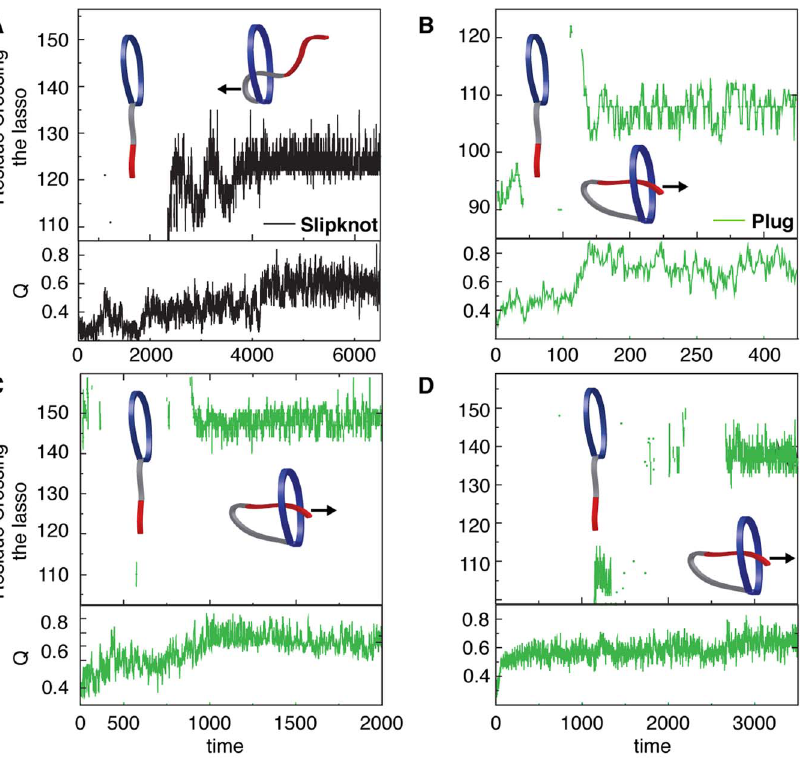
Figure 5. The threading mechanism of the N-terminal PLB proteins. ( A ) The threading mechanism for mIL-3 where slipknotting is the major event (black). We also observe cases where the C-terminal region remains random and no apparent lasso crossing is observed (see cartoon). Panels B-D show the predominance of the plugging mechanism for hIL-3, IFN w -1 and IFN w -2, respectively. In this mechanism the C-terminal pierces through the N-terminal loop as is shown in the cartoon. As in (A) we also observe cases where the C-terminal region remains random and no apparent lasso crossing is observed (see cartoon).